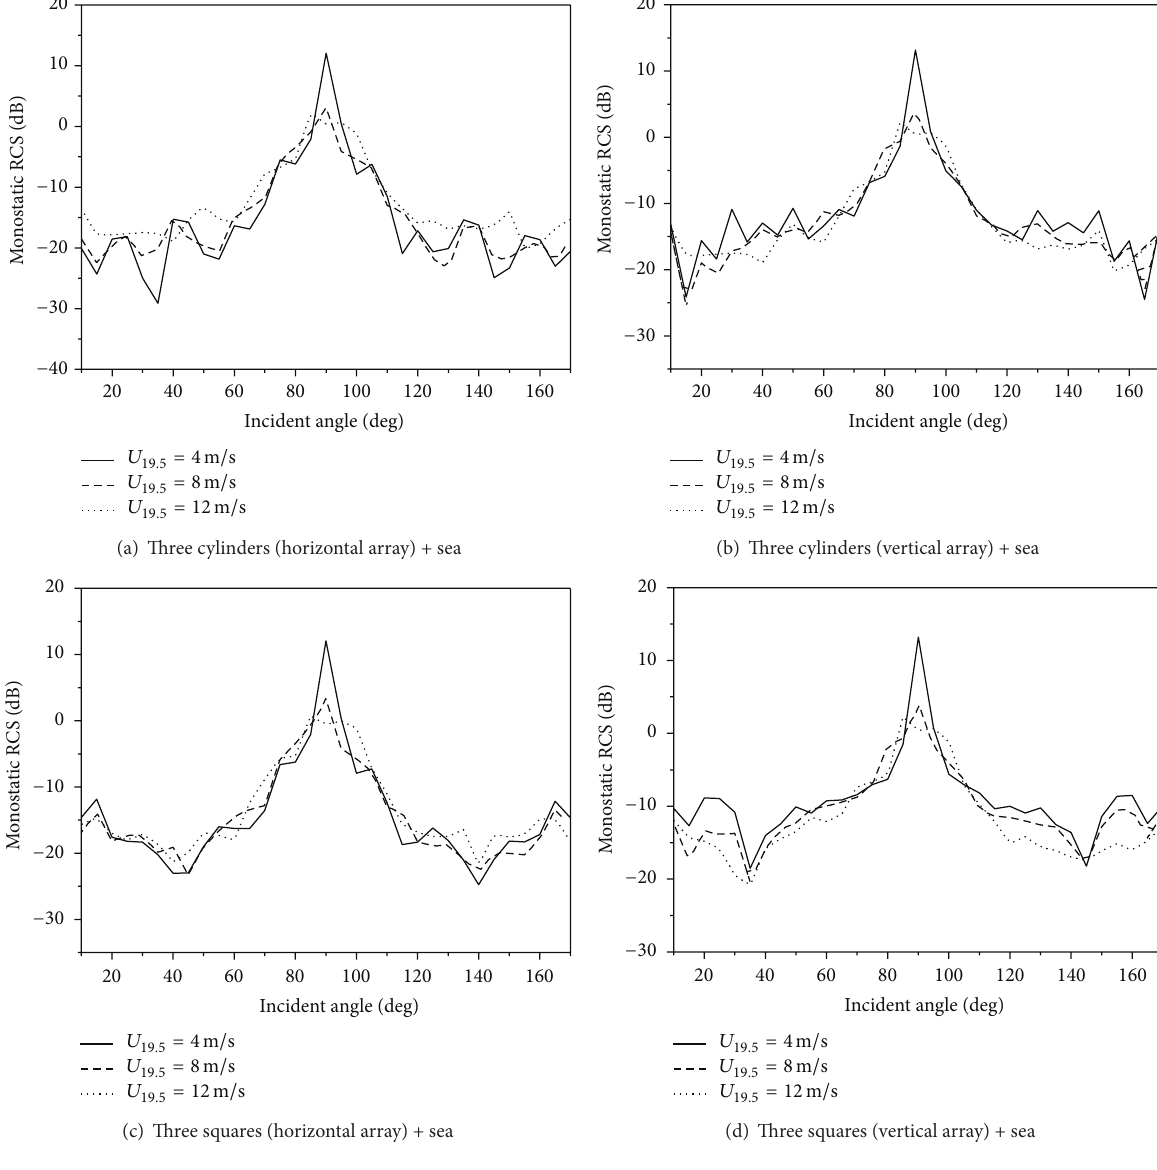
Figure 8: Monostatic RCS of three objects over the rough sea surface of different 𝑈 19.5